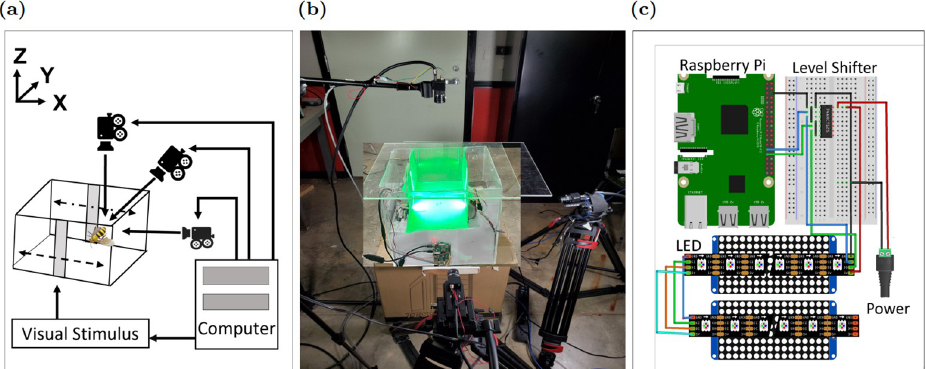
Fig 1. (a) Diagram of tracking system, (b) physical implementation, (c) input stimulus circuit